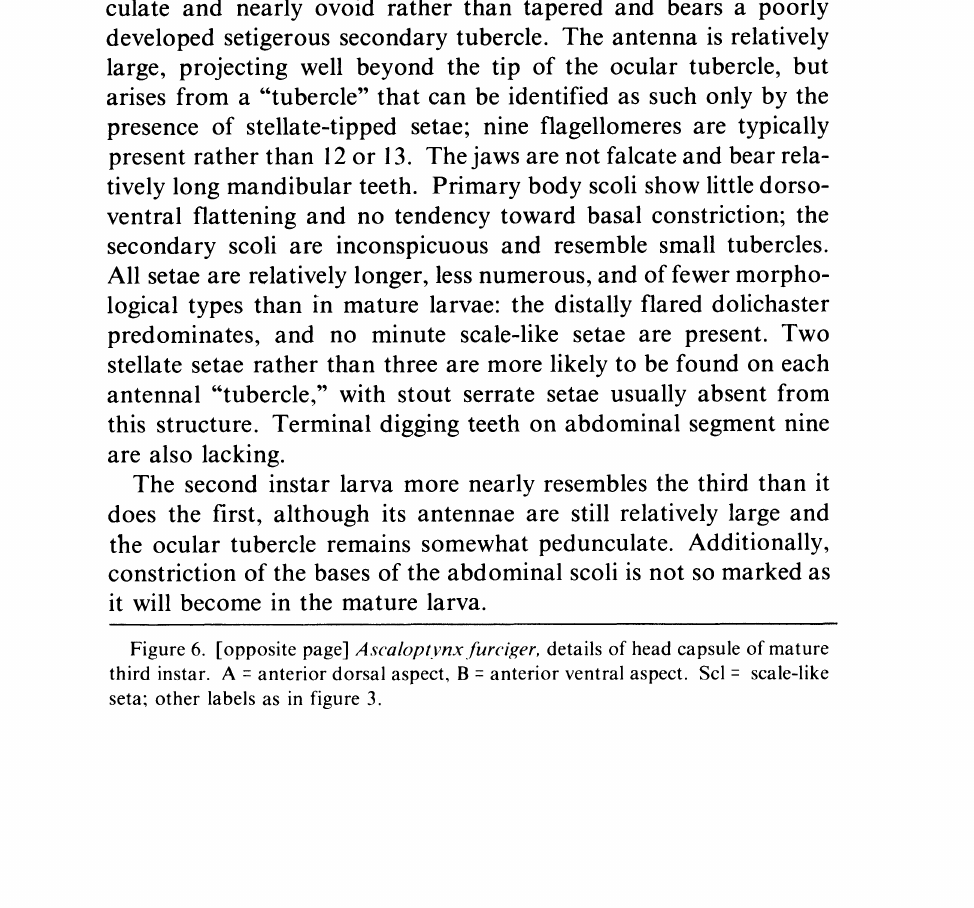
Figure 6. [opposite page] Ascalopt.vnxfurciger, details of head capsule of mature third instar. A anterior dorsal aspect, B anterior ventral aspect. Scl scale-like seta; other labels as in figure